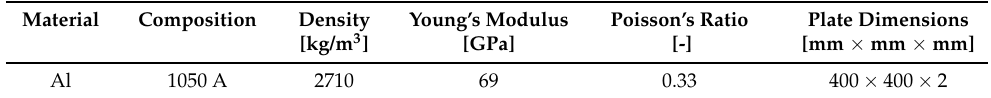
Table 1. Material properties and plate